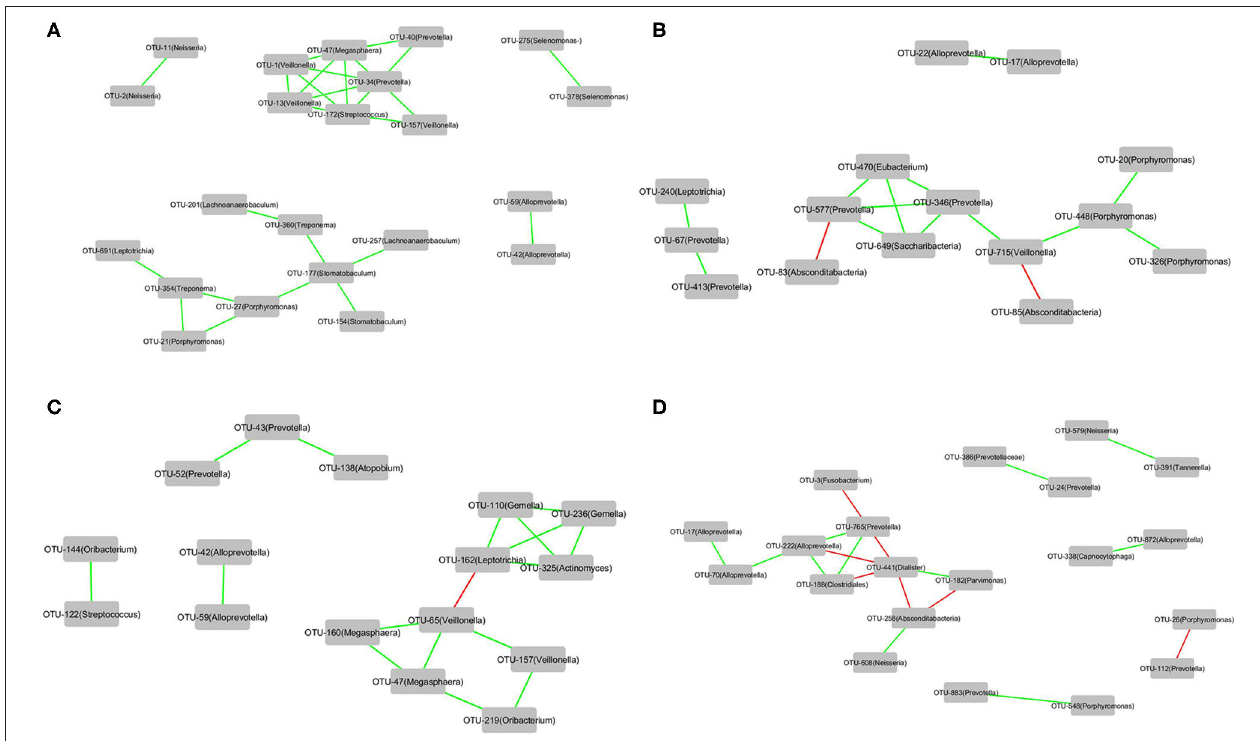
FIGURE 7 | The correlations of the OTUs that were associated with (A) Cluster_1_H7N9_NSI, (B) Cluster_2_H7N9_NSI, (C) Cluster_1_H7N9_SBLI, and (D) Cluster_2_H7N9_SBLI.